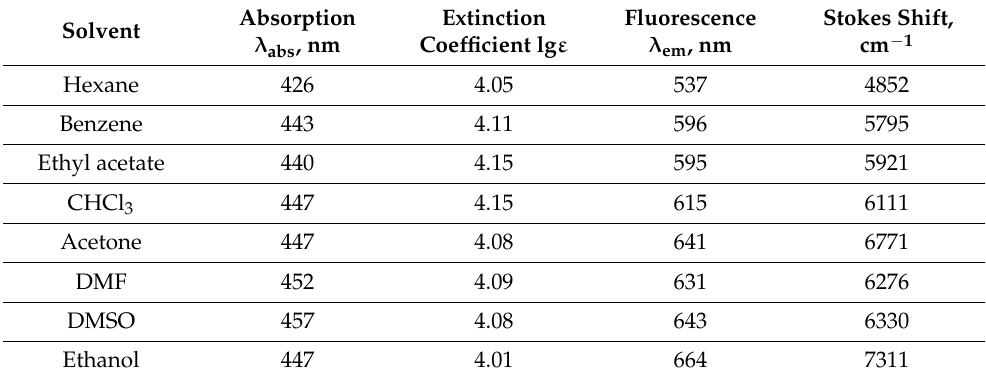
Table 2. Photophysical parameters of compound 2 in various solvents (concentration is 10 − 5 mol l − 1 ).